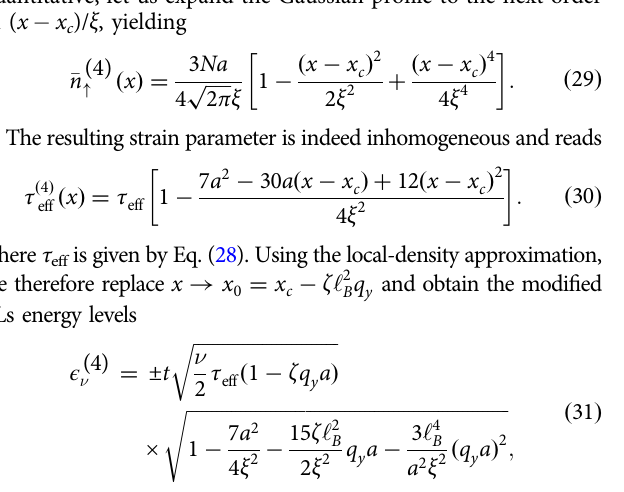
Fig. 8 Energy spectrum for the non-interacting regime. Spectrum of ^ H eff when the Bose – Einstein condensate of the ↑ atoms is in the non- interacting regime. The number of sites along x is N x = 1401, the strength of the harmonic con fi nement is V x = 5.8 × 10 − 11 J / a 2 , the number of bosons is N ↑ = 4.8 × 10 5 and the interspecies interaction strength is α = 0.49. The strain intensity is τ eff = 3.1 × 10 − 3 . Dashed lines represent the predicted Landau energies for a homogeneous synthetic magnetic fi eld, whereas the dashed-dotted lines are obtained by including the leading effects of